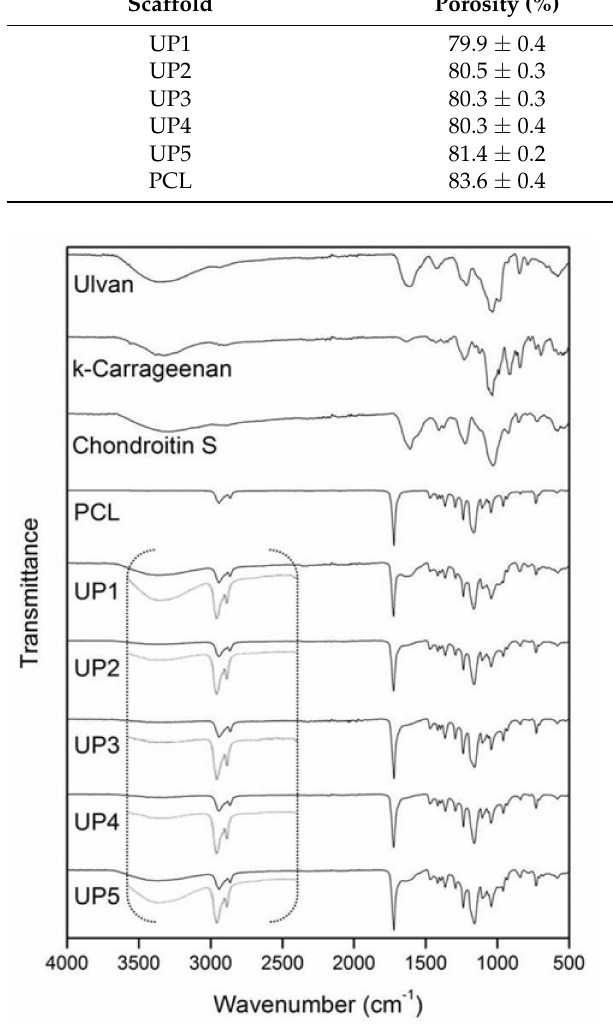
Figure 3. FTIR spectra of ulvan, κ -carrageenan, chondroitin sulfate, polycaprolactone (PCL) and UP